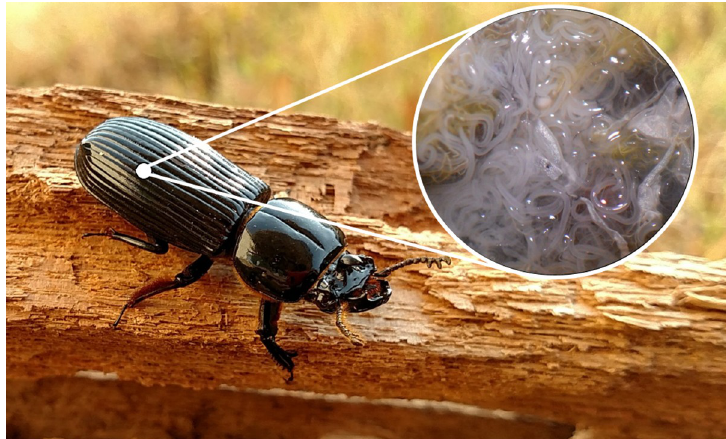
Fig 1. Horned passalus beetle, Odontotaenius disjunctus , on a log. This species is common in hardwood forests throughout the eastern United States. Inset image shows its naturally-occurring nematode parasite, Chondronema passali , which inhabits the abdominal cavity. Beetle photographed by Stuart Sims, Athens,